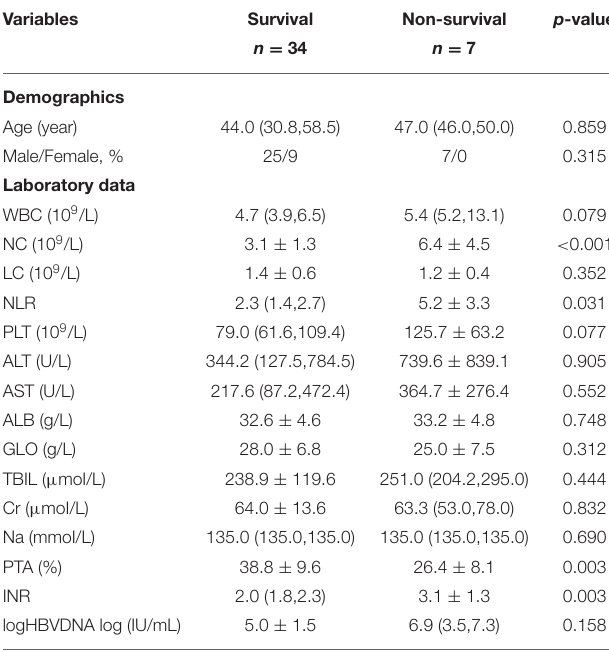
TABLE 2 | Characteristics of the survival and non-survival groups in patients with HBV-ACLF. Variables